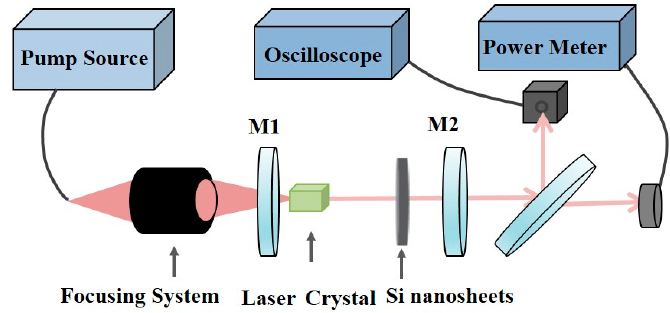
Figure 3. Experimental set-up of the Si nanosheets Q-switched solid-state laser.